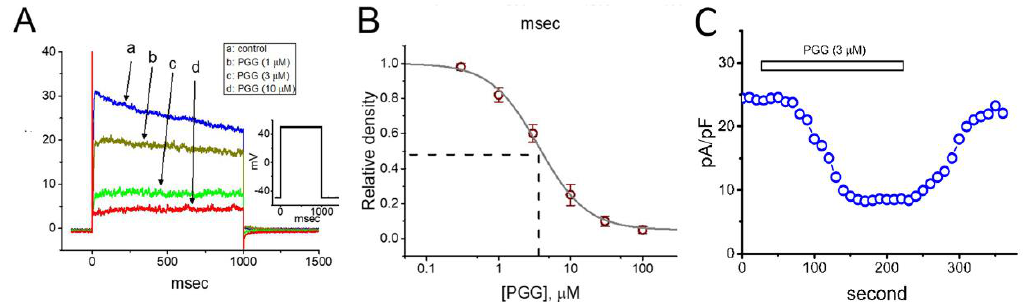
Figure 1. Inhibitory e ff ect of PGG on the amplitude of delayed-rectifier K + current ( I K(DR) ) measured from pituitary tumor (GH 3 ) cells. In these whole-cell experiments, we kept cells to be bathed in Ca 2 + -free Tyrode’s solution containing 1 µ M tetrodotoxin, and the recording pipette was filled with K + -containing solution. The composition of these solutions is elaborated in the Materials and Methods. ( A ) Representative I K(DR) density evoked during 1-sec square-voltage command from − 50 to + 50 mV (indicated in the Inset). a: control; b: 1 µ M PGG; c: 3 µ M PGG; d: 10 µ M PGG. ( B ) Concentration-dependent inhibition of I K(DR) density produced by the presence of di ff erent PGG concentrations (mean ± SEM; n = 8). The continuous sigmoidal line over which the data points are overlaid is appropriately fitted by the three-parameter logistic model (i.e., modified Hill equation). The vertical dashed line is placed at the IC 50 value (i.e., 3.6 µ M). ( C ) Time course for the